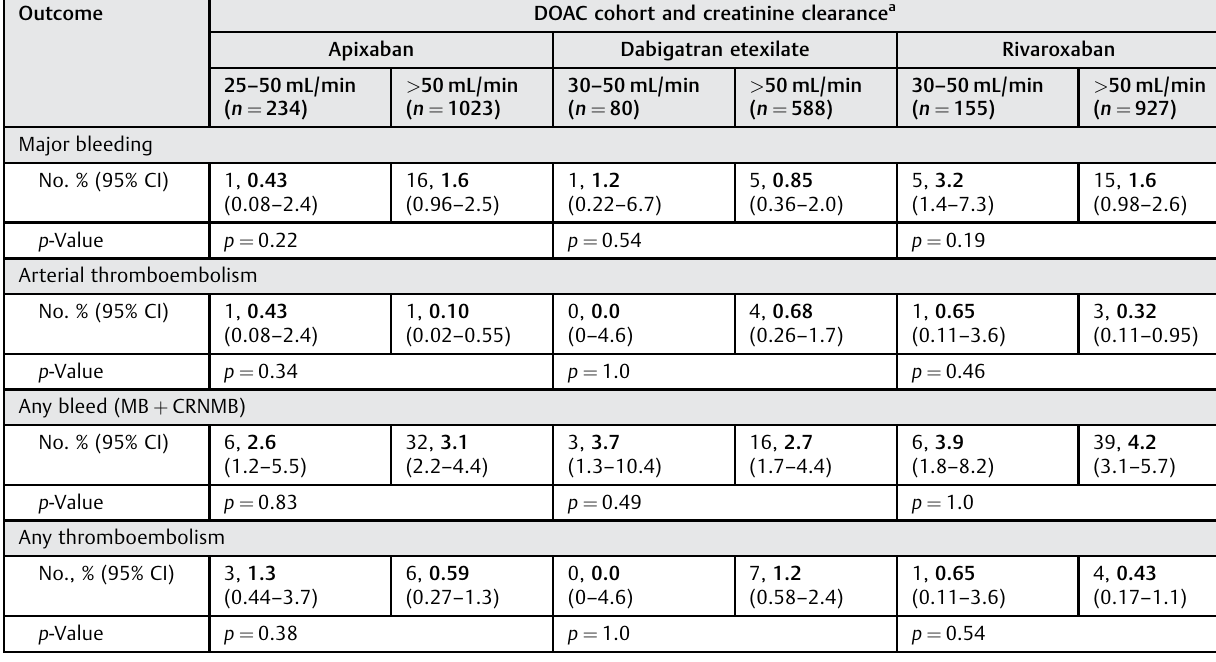
Table 5 Effect of renal function on clinical outcomes